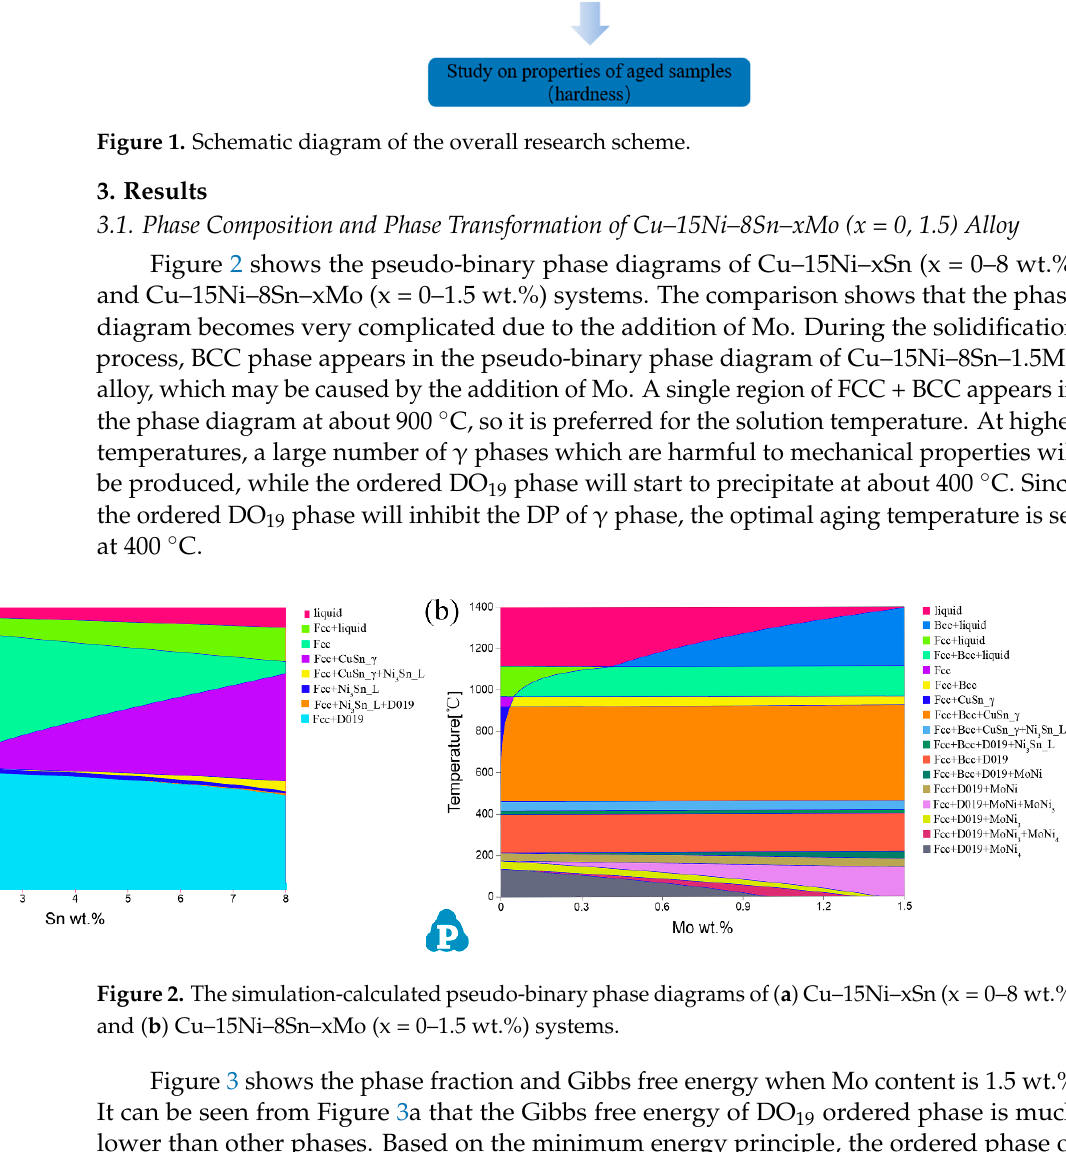
Figure 1. Schematic diagram of the overall research scheme.